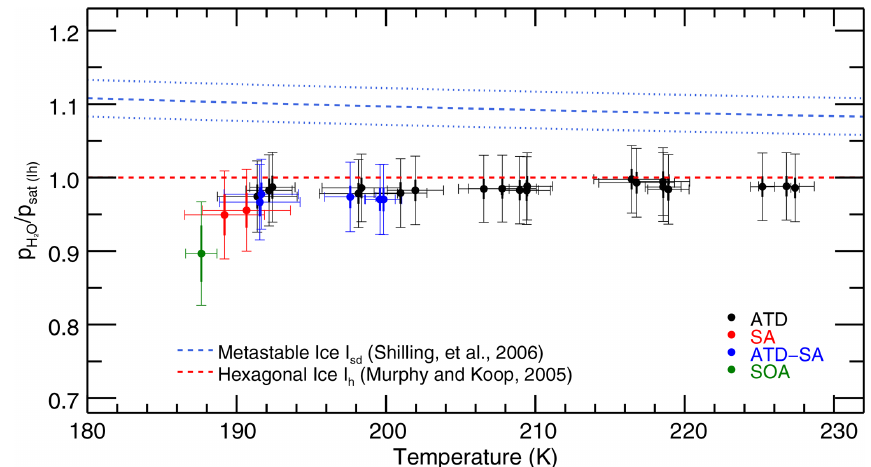
Figure 5. Retrieved saturation vapor pressures for the 28 IsoCloud experiments fitted, expressed as a fraction of MK saturation, and plotted against mean experiment temperature. The red dashed line represents MK saturation. The blue dashed line represents the Shilling et al. (2006) value for the vapor pressure of metastable ice, and the blue dotted lines show the errors of that measurement. Experiments are colored by aerosol/IN type: Arizona test dust (ATD, black), liquid sulfuric acid droplets (SA, red), secondary organic aerosol (SOA, green), and experiments containing both ATD and SA (blue). All experiments that include solid dust (black, blue) undergo heterogeneous nucleation; those with SA or SOA only (red, green) undergo homogeneous nucleation. Horizontal error bars are the standard deviation of the temperatures over the fit region. Vertical error bars show both the 1 σ instrumental uncertainty (thick width), which is greater at colder temperatures, and the larger systematic linestrength uncertainty (thin width), which is identical for all experiments. Derived saturation vapor pressures in general are consistent with MK (to within systematic uncertainty), and exhibit no trend with temperature for each aerosol type (to within instrumental uncertainty). Note that the fitting procedure means that Experiment 33, the outlier in Fig. 3, yields a saturation vapor pressure consistent with other experiments. Experiments do show lower values in the cases where liquid aerosols are present. Compare to Fig. A2 in Fahey et al. (2014).